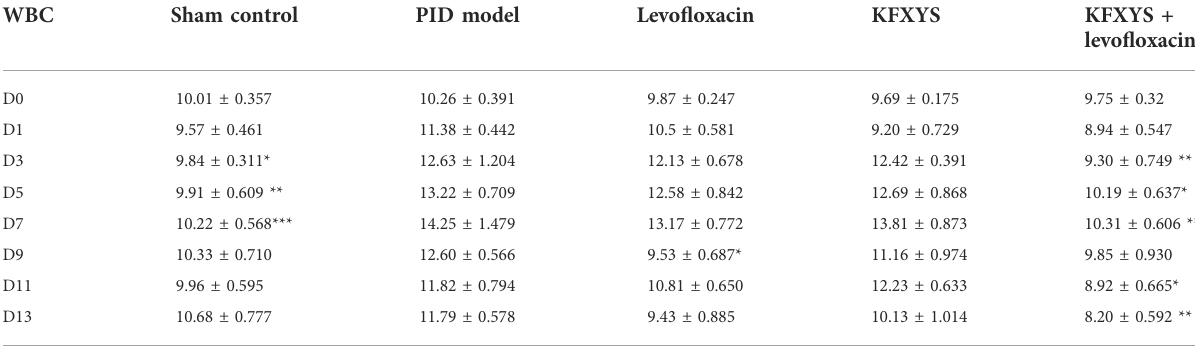
TABLE 3 Changes of white blood cell (WBC) of rats in acute in fl ammatory stage [n = 7, ‾ X ± sem,*10 9 cells/L)].